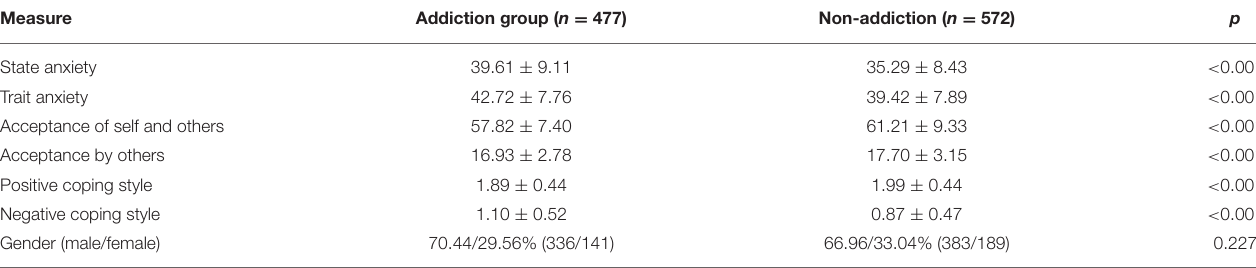
TABLE 2 | Comparisons between addiction group and non-addiction group.